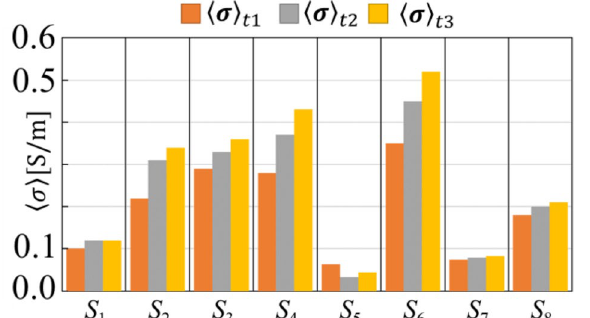
Figure 9. Spatial mean of gastric conductivity